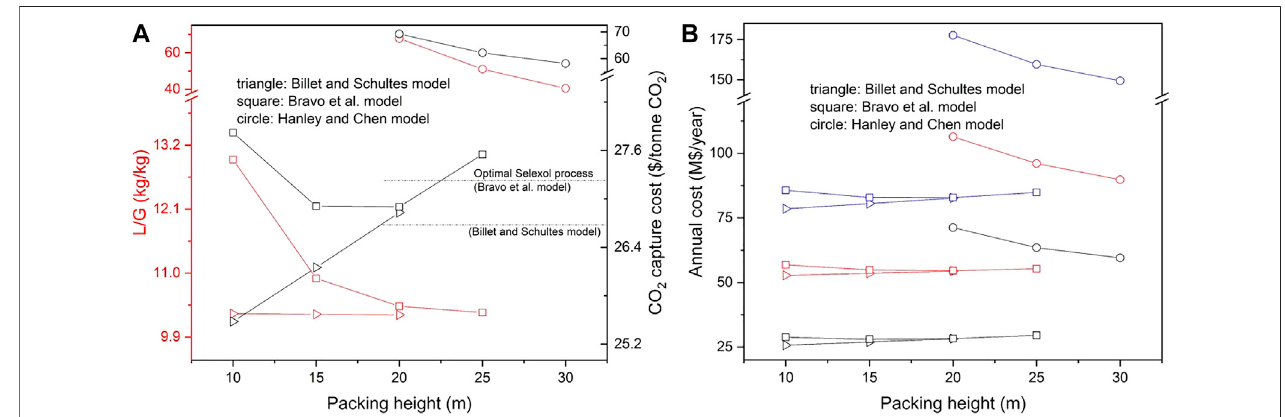
FIGURE 5 | (A) The variation of L/G ratio along with the packing height for ATPPB-DEG (1:10). Red lines and symbols refer to the left red axis, black lines and symbols refer to the right black axis; (B) The variation of CO 2 capture cost along with the packing height for ATPPB-DEG (1:10). Black/red/blue samples and symbols refer to capital/operating/total annual cost, respectively.